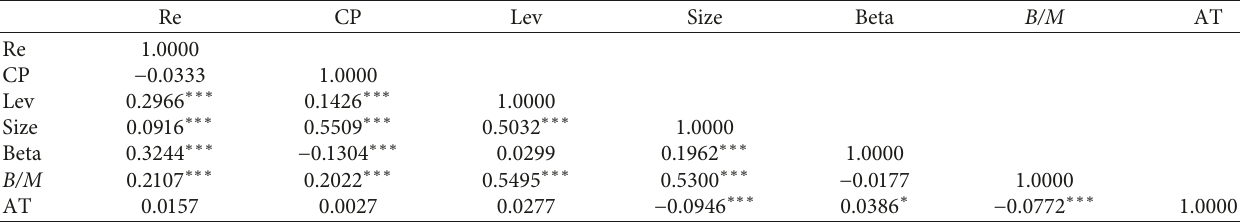
Table 3: Correlation coefficient of each variable of the whole